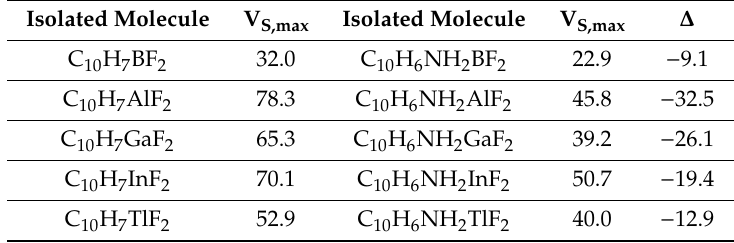
Figure 2. MEPs of ( a ) C 10 H 7 GaF 2 and ( b ) C 10 H 6 NH 2 GaF 2 . Blue and red regions refer, respectively, to + 0.02 and − 0.02 au. Table 2. Maxima in MEP (kcal / mol) of isolated C 10 H 7 TrF 2 and C 10 H 6 NH 2 TrF 2 monomers calculated at the MP2 / aug-cc-pVDZ level of